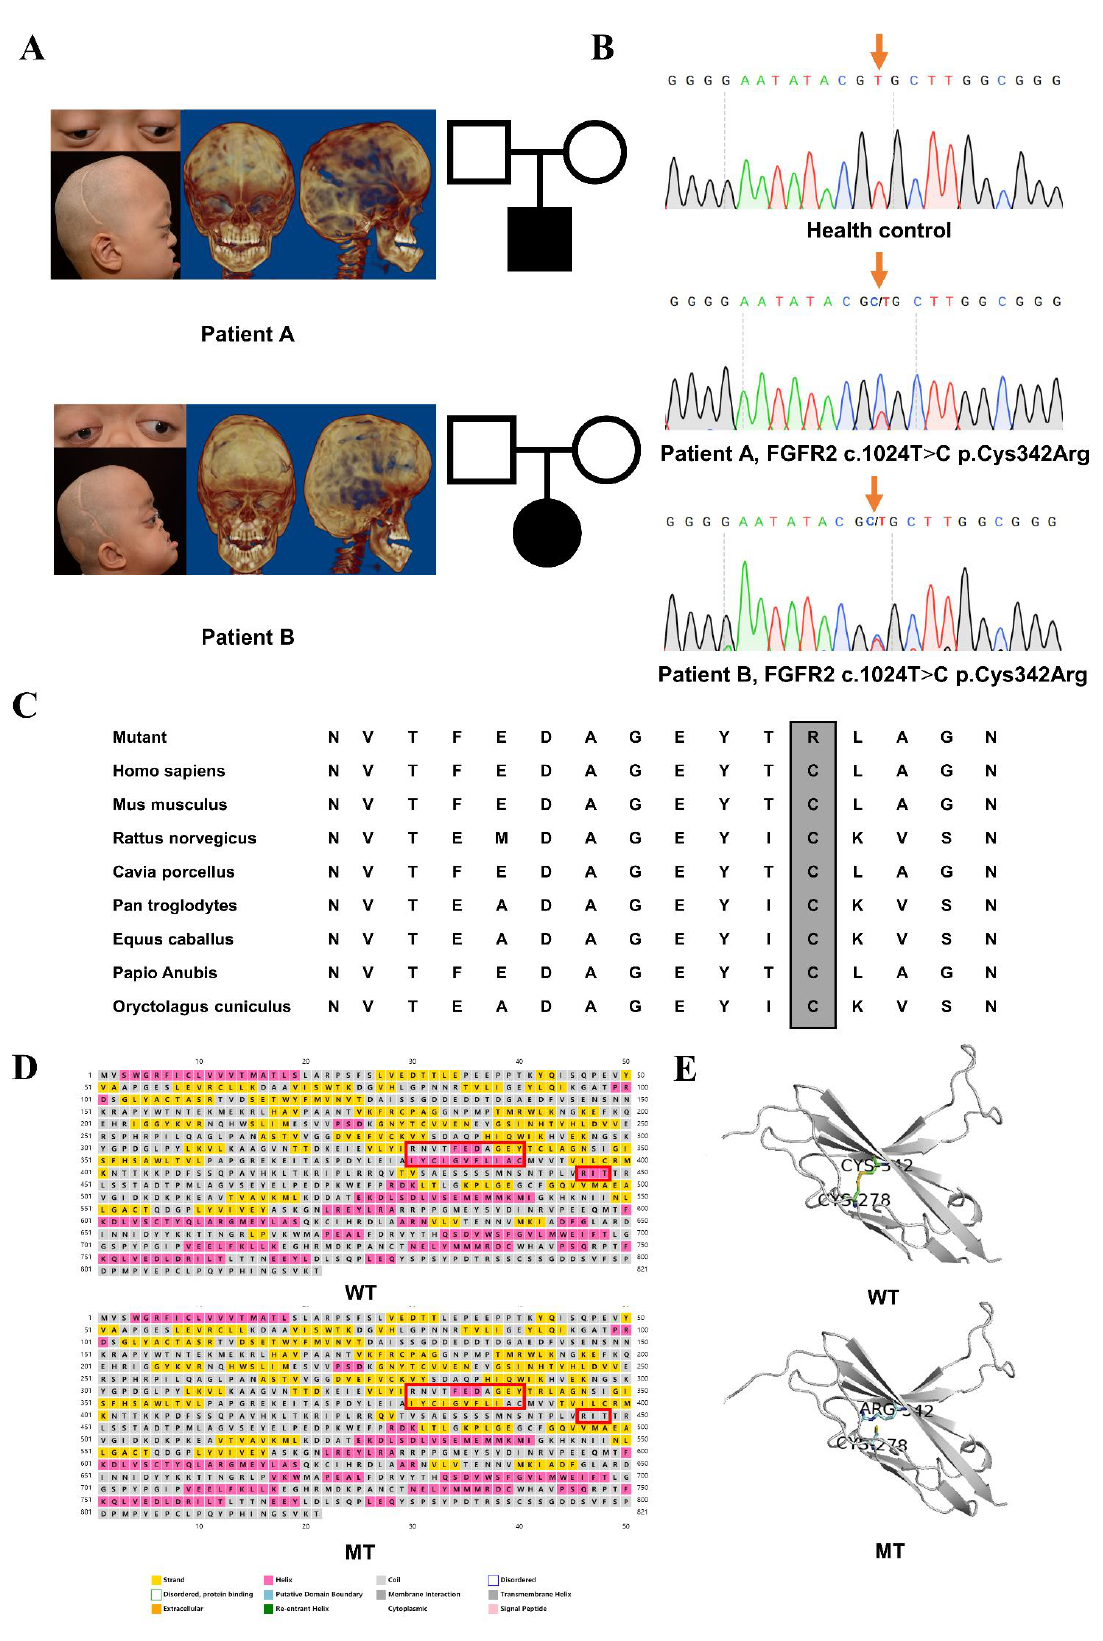
Figure 1. Clinical findings, identified mutation and pathogenic assessments: ( A ) Digital photos and CT of two sporadic Chinese children with Crouzon syndrome after cranial vault reconstruction. Both of them suffered from the premature closure of the bilateral coronal sutures,